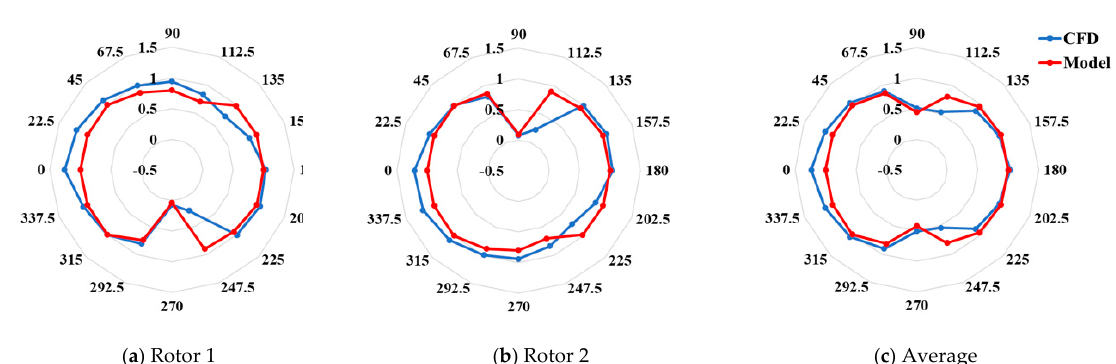
Figure 14. Distributions of normalized rotor powers in the IR − configuration in the case of gap = 0.5 D : ( a ) Rotor 1; ( b ) Rotor 2; ( c ) average.